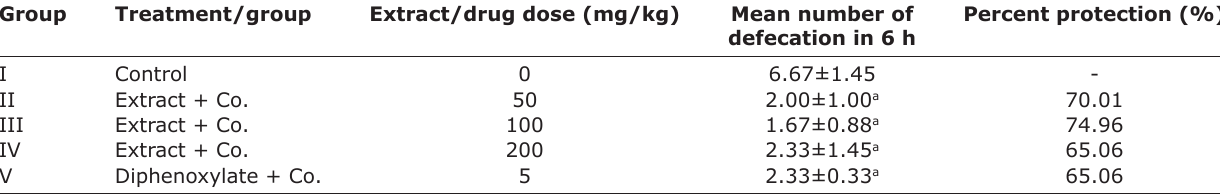
Table-1: Effect of aqueous root bark extract of Byrsocarpus coccineus on castor oil-induced diarrhea in albino rats. Group